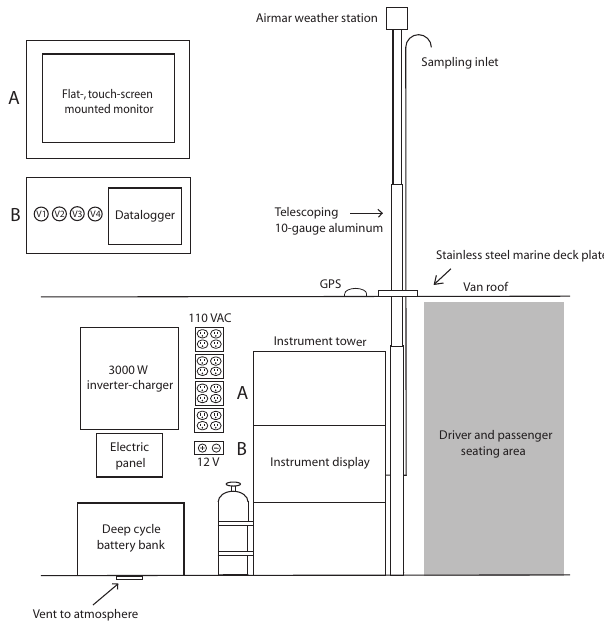
Figure 1. Schematic of mobile laboratory components and orienta- tion. The viewing angle is from the passenger side of the vehicle. Letters A and B show panel components mounted to the instrument rack, which face the rear of the